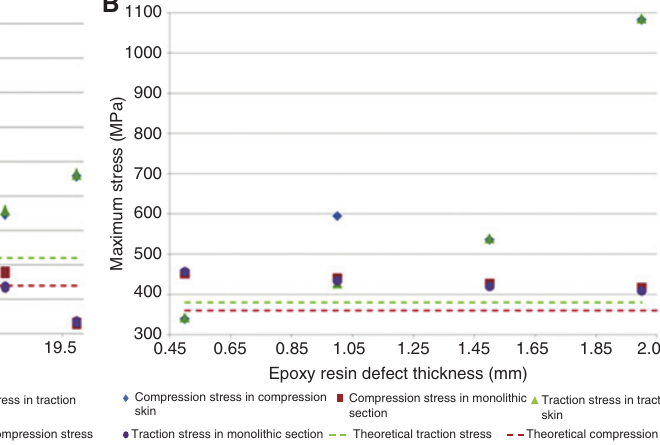
Figure 11 Influence of defect height and thickness in